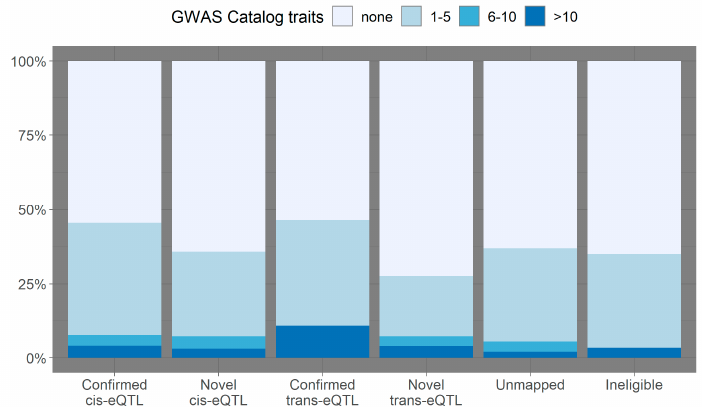
Figure 2. GWAS trait-associations reported for eQTL in the PAH Cohort. Percentage of binned numbers of overlapping GWAS traits ( y -axis) per eQTL in each eQTL category ( x -axis). Reported genotype-trait associations were downloaded from the NHGRI-EBI Catalog of published genome- wide association studies.